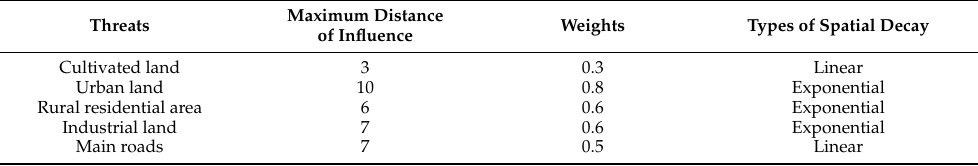
Table 1. Habitat threats and their attributes.